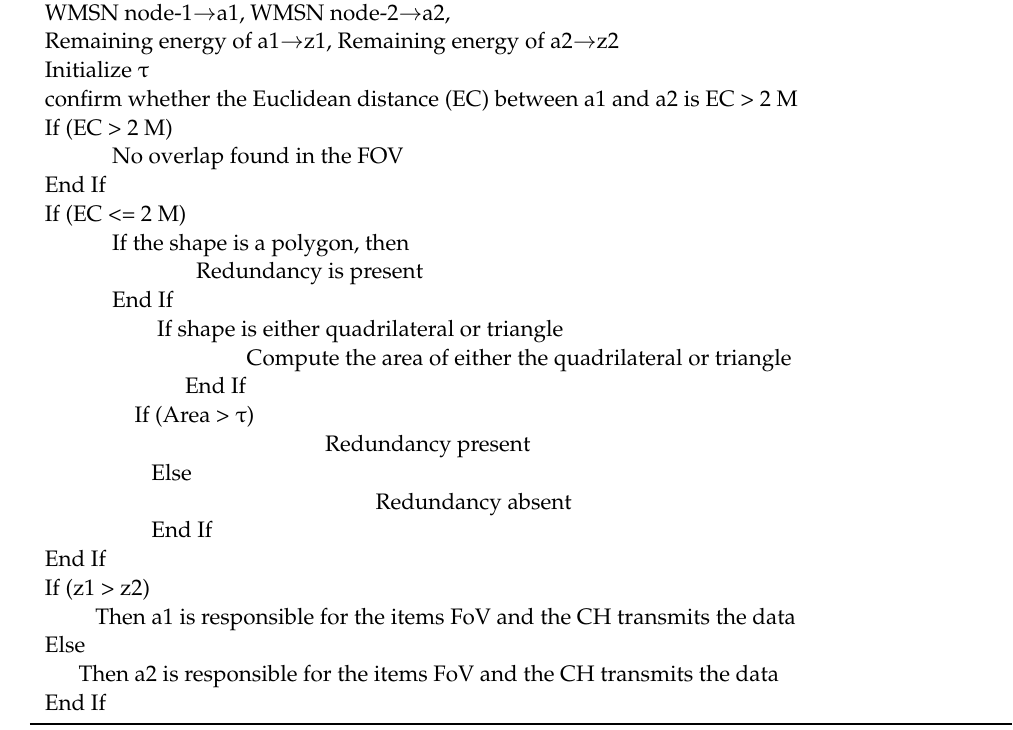
Algorithm 1: Data redundancy model